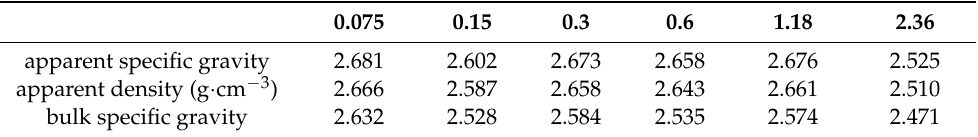
Table 1. Density of fine aggregate.